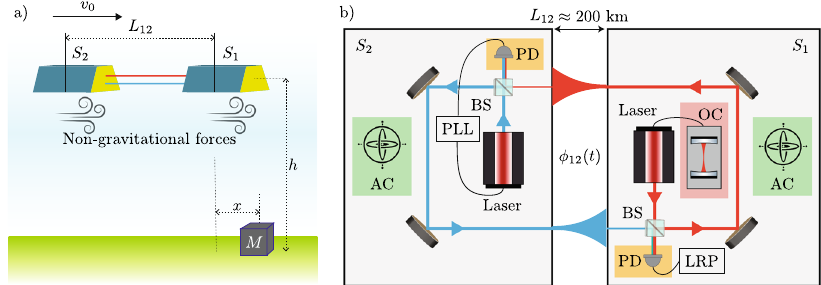
Fig. 1 Schematic of satellite geodesy. a Current GRACE-FO formation. Two satellites separated by a distance L 12 fl y over a mass M at a height h above the Earth. The differential acceleration allows information about the gravitational fi eld to be recovered. b Detailed schematic showing the main noise sources in the current GRACE-FO mission, highlighted in different colours. Satellite S 1 is designated as the master satellite and sends out a laser beam stabilised to an optical cavity (OC), which determines the laser phase noise (red box). The second satellite, S 2 , returns a laser beam phase locked to this at a 10 MHz offset. Inherent fl uctuations in the number of photons manifest as quantum noise, highlighted at the photodetection stage (orange boxes). There are also non-gravitational forces which affect the motion of the two satellites (highlighted in blue in a . Non-gravitational acceleration arises from a variety of sources, including aerodynamic drag and solar radiation pressure. Non- gravitational acceleration can be measured and removed at the expense of introducing accelerometer instrument noise (green box). Measurement instruments include accelerometer (AC), photodetector (PD), beam-splitter (BS), phase locked loop (PLL) and laser ranging processor